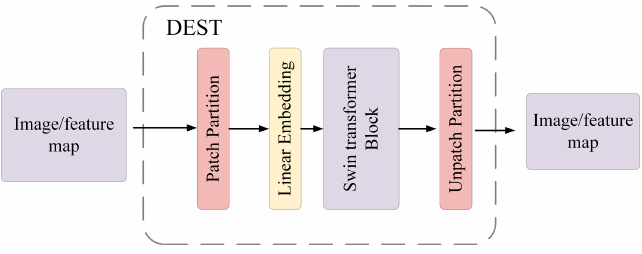
Figure 3. The derain Swin Transformer (DEST) block.